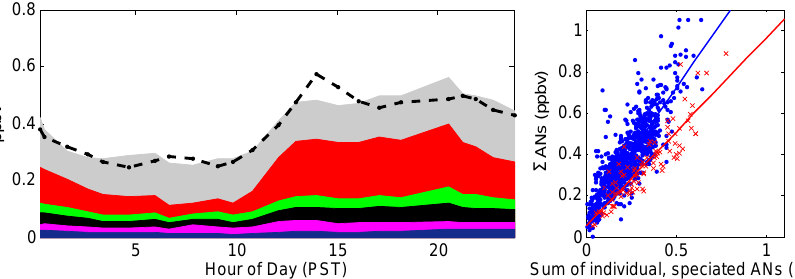
Fig. 3. (a) Comparison of CIMS and TD-LIF measurements during the last two weeks of the campaign (Julian days 199–212). 6 ANs as measured by TD-LIF are shown as the dashed line. Speciated organic nitrates are shown in the colors. The gray fraction represents the sum of other organic nitrate species observed with the CIMS (Table 2). Red = ISOPN, Green = PROPNN, Black = MVKN+MACRN, Magenta = MBON, Blue = ETHLN. (b) In blue, 6 ANs (measured with TD-LIF) vs. the sum of individual nitrates (measured with CIMS), not including the data in the gray portion. Equation for the linear fit is y = 1 . 25 x + 0 . 096, R 2 = 0 . 85. In red, 6 ANs (measured with TD-LIF) vs. the sum of individual nitrates (measured with CIMS), including the data in the gray portion. Equation for the linear fit is y = 0 . 91 x + 0 . 052, R 2 = 0 . 89. There are fewer data points for the data shown in red due to the frequency of data points (approximately once every